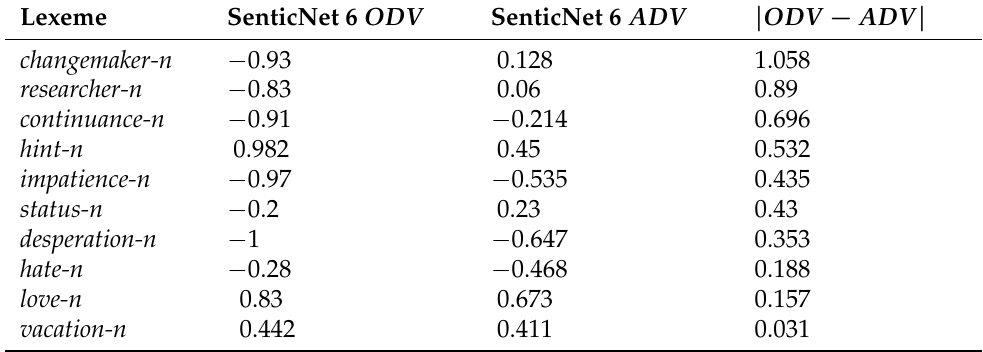
Table 6. Examples of ODV and ADV calculated with SenticNet 6 polarity_value on ententen13